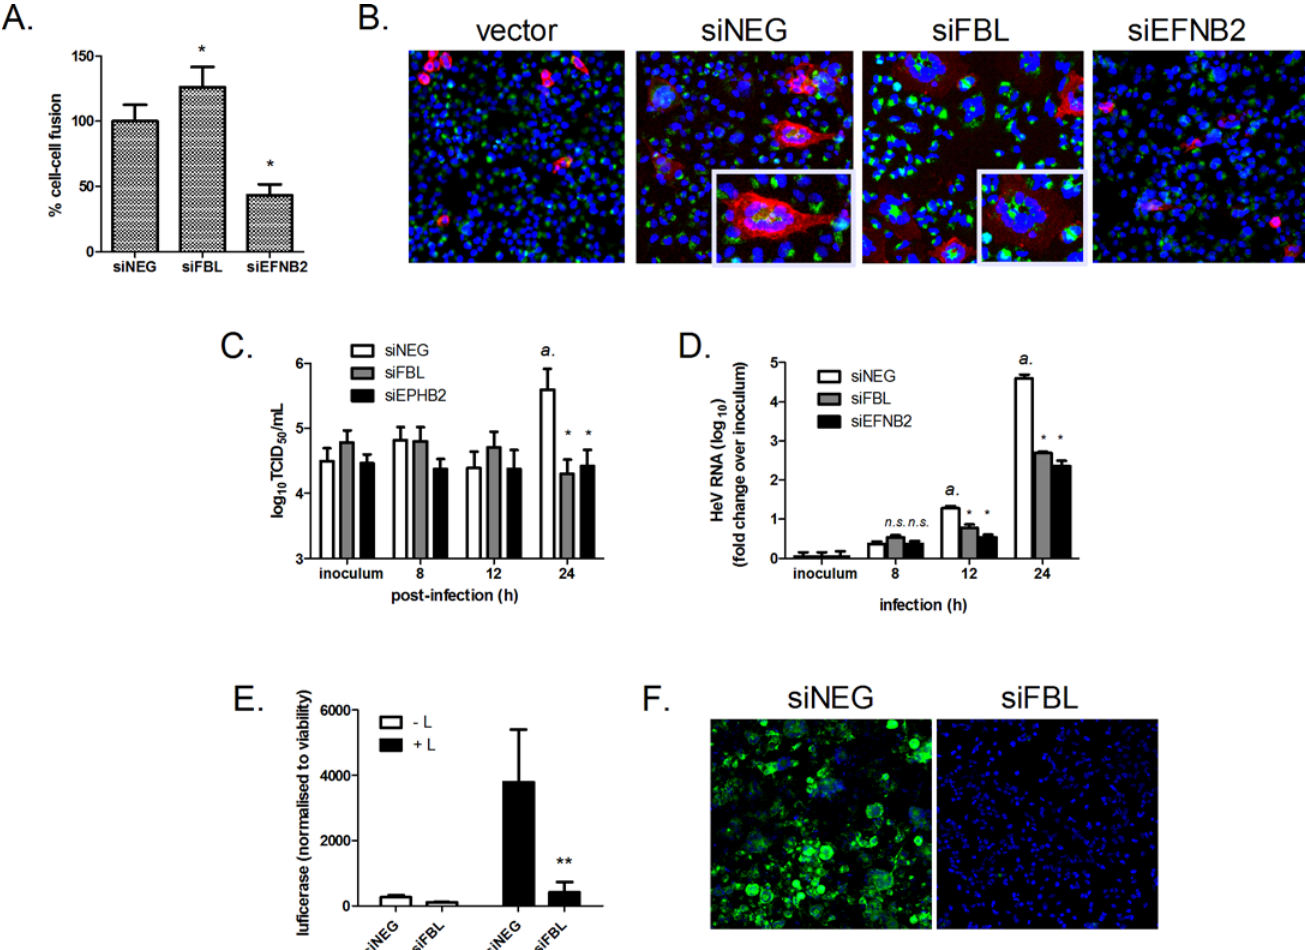
Fig 4. FBL is essential for the early stages of HeV infection post-entry. (A) Cell-to-cell fusion of HeV-F and HeV-G-expressing (effector) HEK-293T cells to (target) HeLa cells treated with indicated siRNAs. Values are normalised to siNEG, set to 100. * p < 0.05 compared to siNEG. (B) Typical fusion visualised by immunofluorescence. Nuclei are shown in blue, target cells green and effector cells red. (C) TCID 50 measurements of virus titres and (D) qRT-PCR measurements of intracellular viral RNA in HeLa cells infected with HeV (MOI 5). a : p < 0.05 compared to inoculum, * p < 0.05 compared to siNEG. HeV RNA values were normalised to cellular 18S levels and to inoculum levels of HeV, set to 1. (E) Levels of transcription and replication in a plasmid-based Nanoluciferase reporter minigenome assay. HeLa cells were transfected with HeV replication support plasmids and minigenome plasmid in cells transfected with siNEG or siFBL. Reporter activity levels were normalised to cell viability (cellular ATP levels). ** p < 0.01 compared to siNEG. (F) Immunofluorescence microscopy showing HeV-P protein staining (green) in HeLa cells transfected with siNEG or siFBL, followed by HeV infection (MOI 0.1, 24